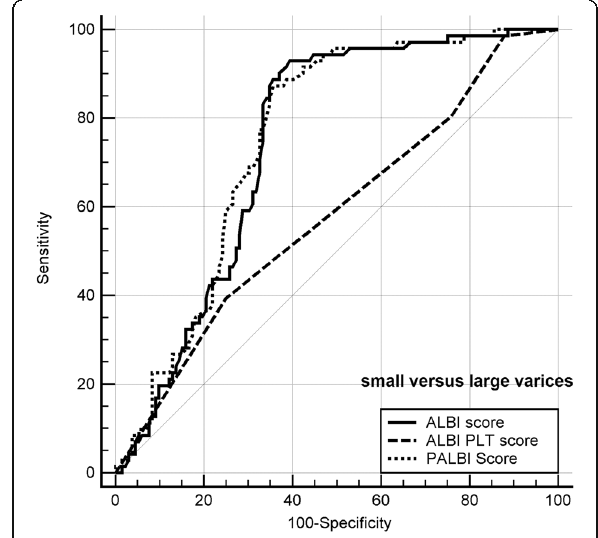
Fig. 3 receiver operating characteristic (ROC) curves analysis of ALBI, ALBI-PLT and PALBI in patients with small versus large